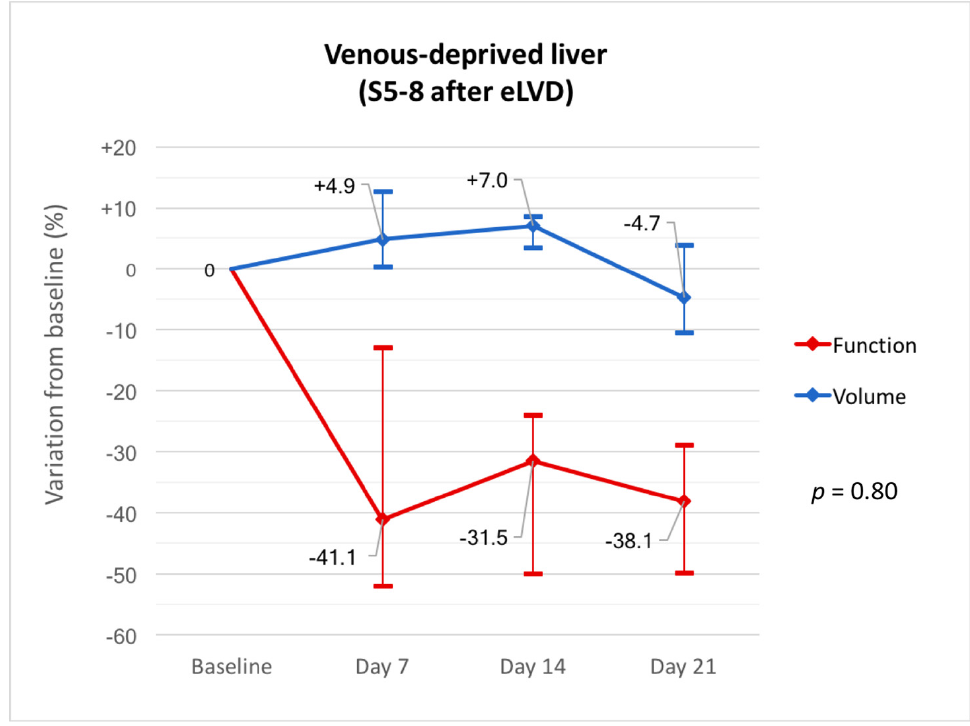
Figure 3. Variations in volume and function from baseline in the venous-deprived liver (S5-8) at days 7, 14 and 21 after eLVD.